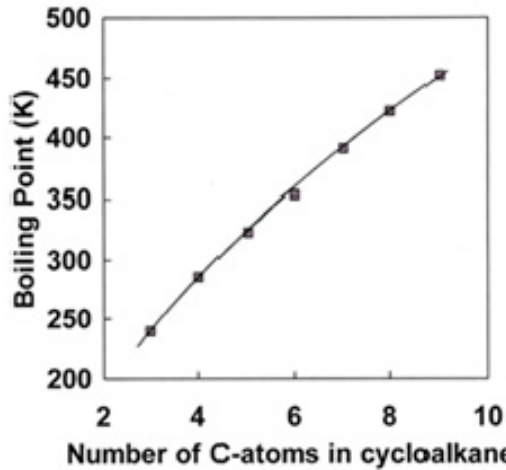
Figure 5. The boiling points of alkanes as a function of chain length.